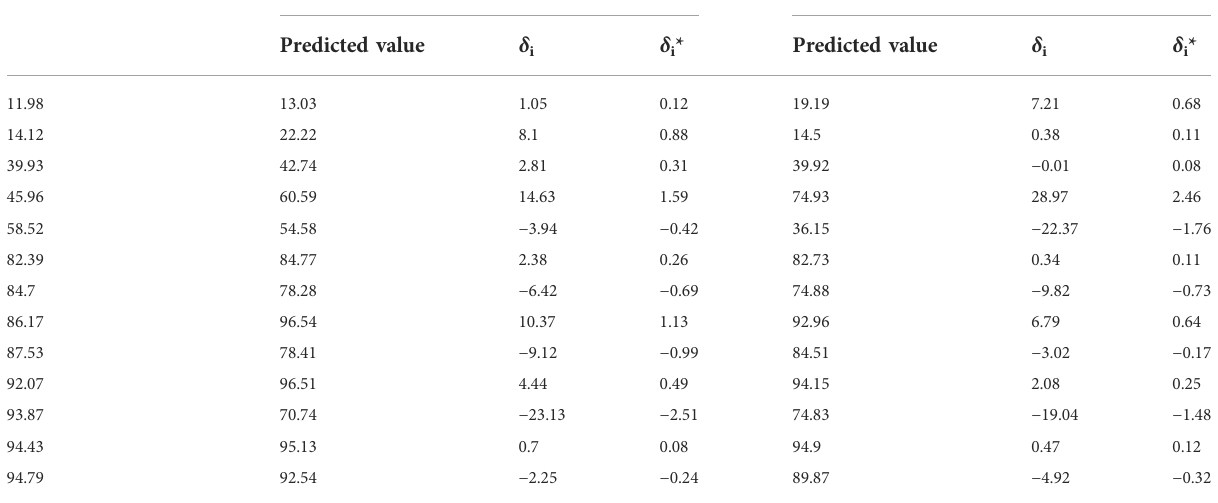
TABLE 2 Neural network prediction pair ratio. Recovery ef fi ciency Multilayer perceptron ( R 2 =0.88) Radial basis function ( R 2